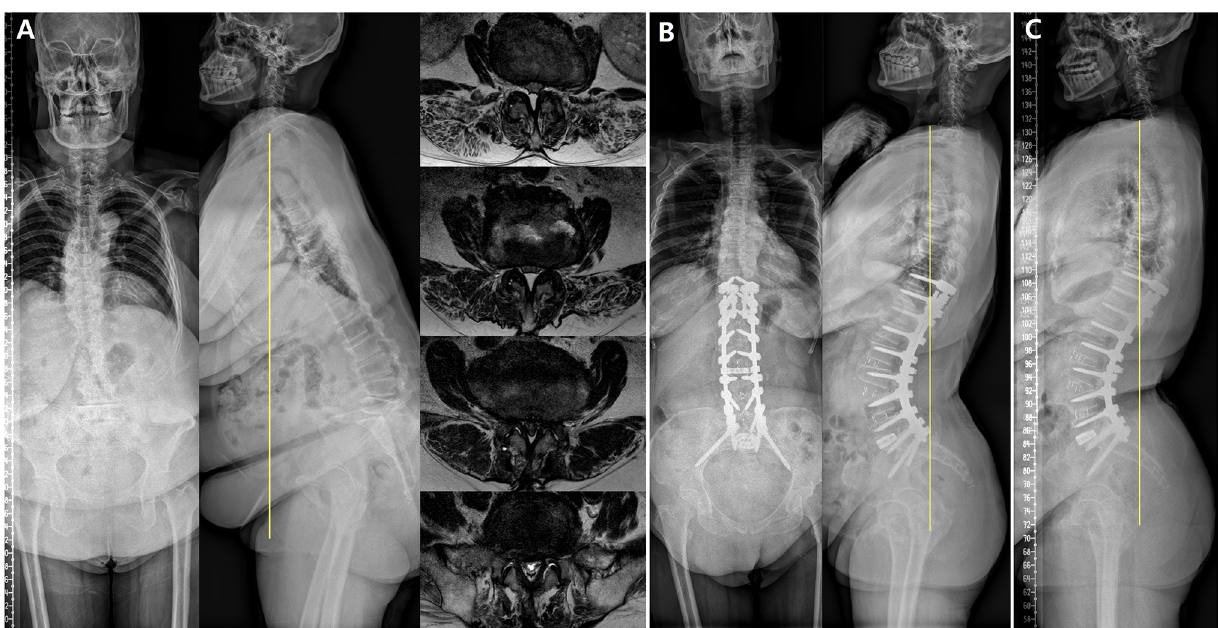
Figure 3. Radiographs showing a 70-year-old female with ( A ) degenerative sagittal imbalance (sagittal vertical axis 167 mm, pelvic incidence 40°, pelvic tilt 31°) who clearly showed atrophy of the back musculature on the cross-sectional area of MRI. ( B ) Oblique lumbar interbody fusion on L2-5, anterior lumbar interbody fusion on L5-S1, and posterior spinal fusion from T10 to S1 was performed (sagittal vertical axis − 60.9 mm, pelvic tilt 6.8°, whole gluteal muscle 1015.5 mm 3 ). ( C ) After performing our basic and gluteal muscle strengthening exercise protocol during 1 year, the radiograph showed a well-maintained optimal sagittal balance and an increased shading of the gluteal muscle (sagittal vertical axis − 54.6 mm, pelvic tilt 12.6°, whole gluteus muscle 1132.7 mm 3